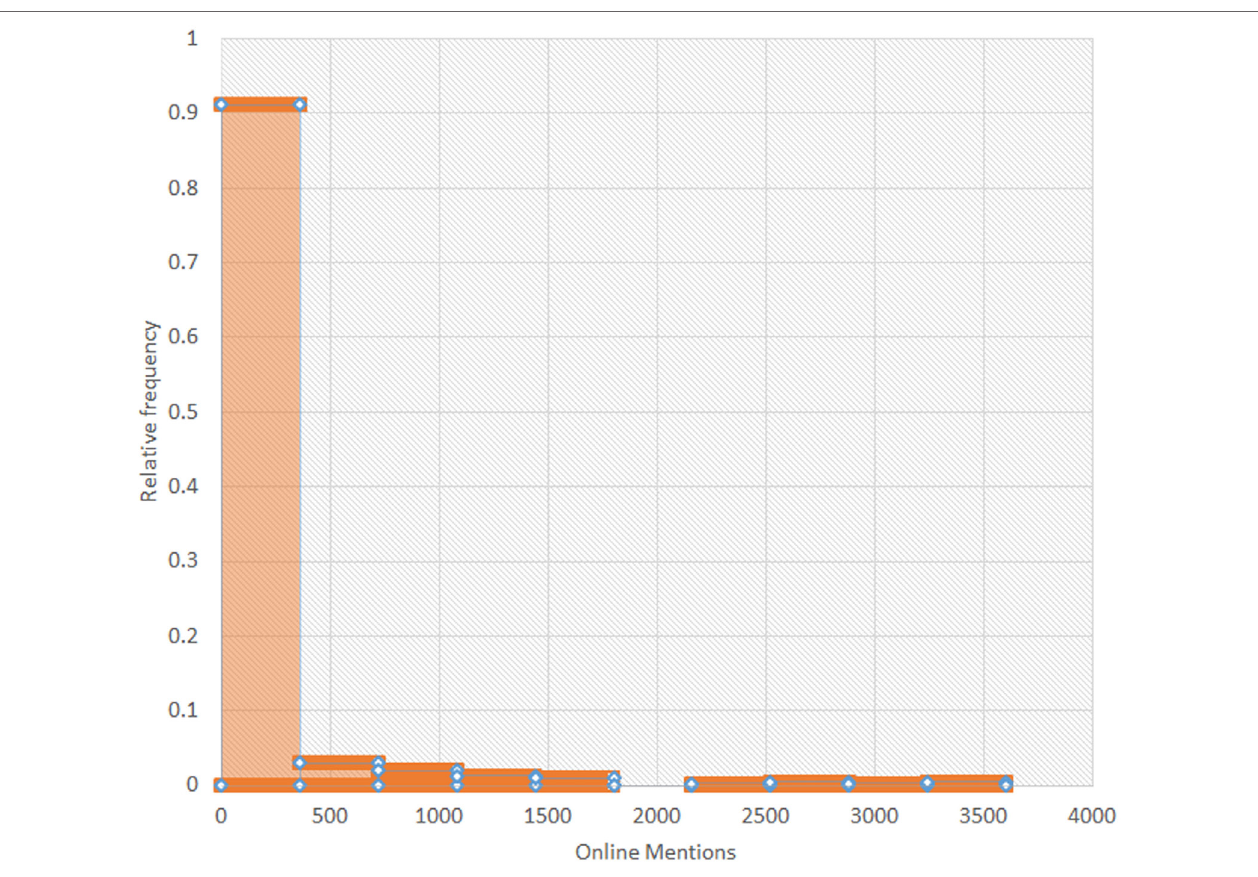
FigUre 4 | Online mentions (ImpactStory) histogram.